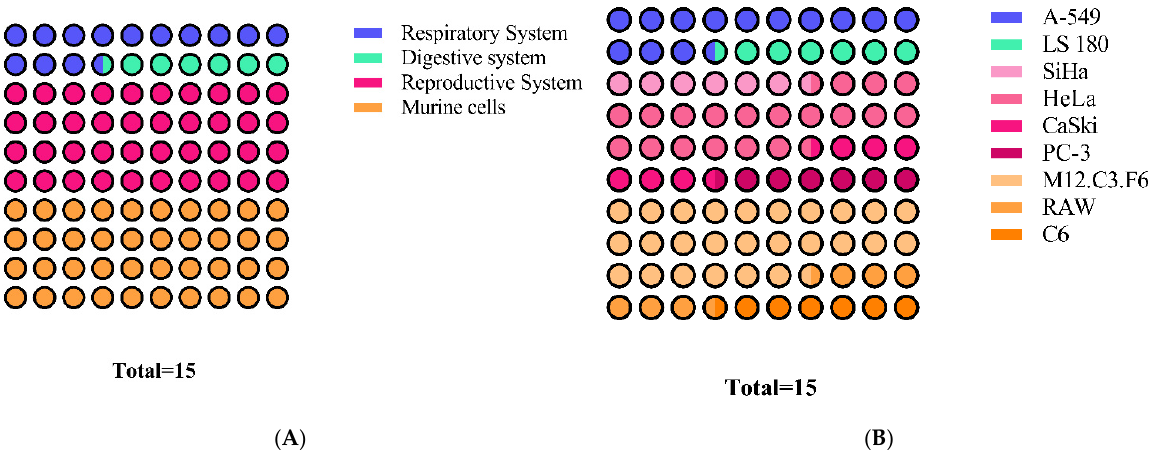
Figure 7. Variety of cell lines inhibited by Mexican propolis. ( A ) The cell lines are divided into systems, and ( B ) into cell lines. All cell lines are shown in shades of the color of the system they belong. Five papers were used. A-549 cell line, effect antiproliferative in LS 180 cell line Hela, M12.C3.F6, PC-3, RAW, C6, SiHa, CaSki, activity against cancer cell line M12.C3. F6 [41,57,137,138,142].